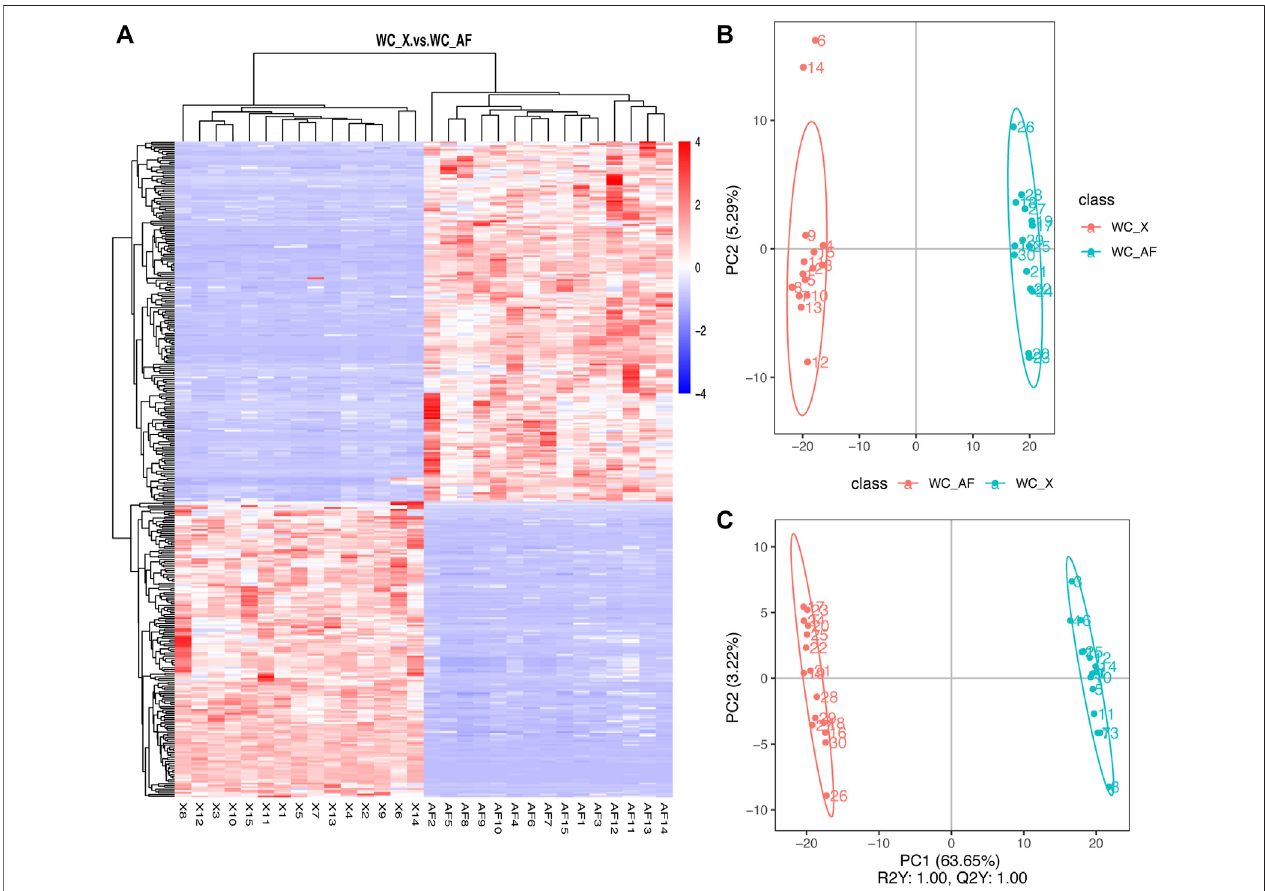
FIGURE 3 | (A) Cluster diagram of all metabolites. (B) PCA of total samples. (C) PLS-DA of total